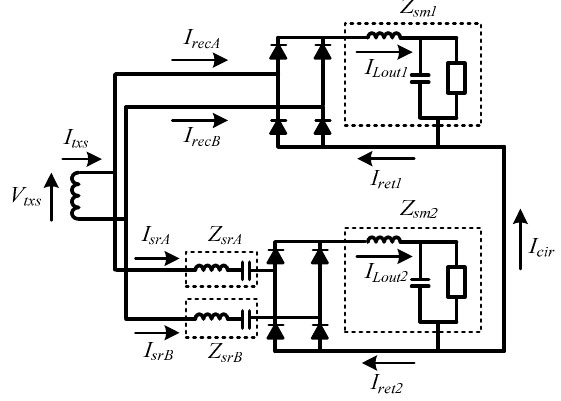
Figure 9. Definition of voltage and current directions.